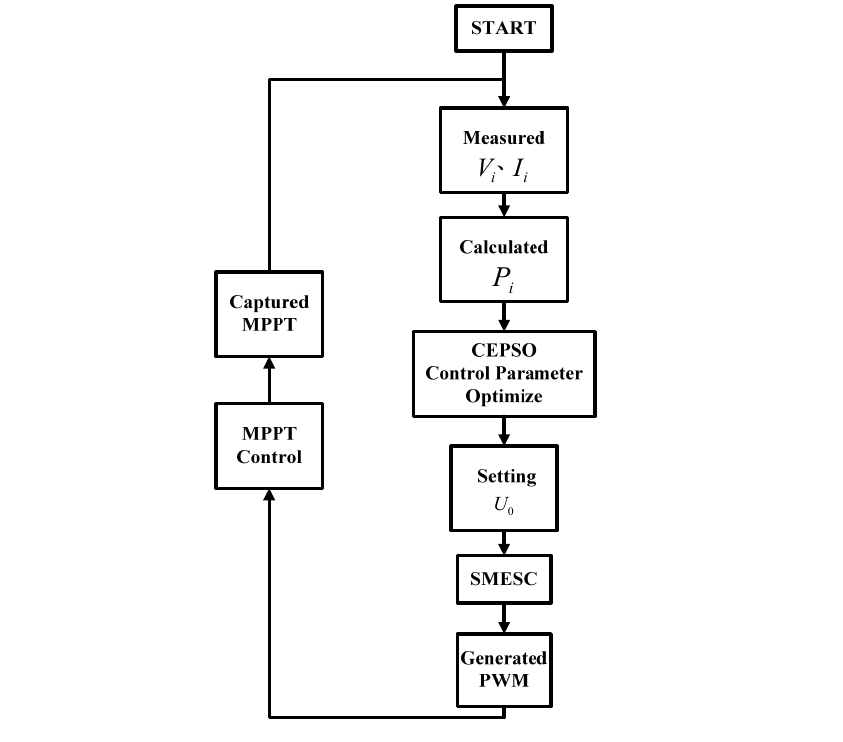
Figure 7. Maximum wind power point tracking flowchart based on CEPSO’s